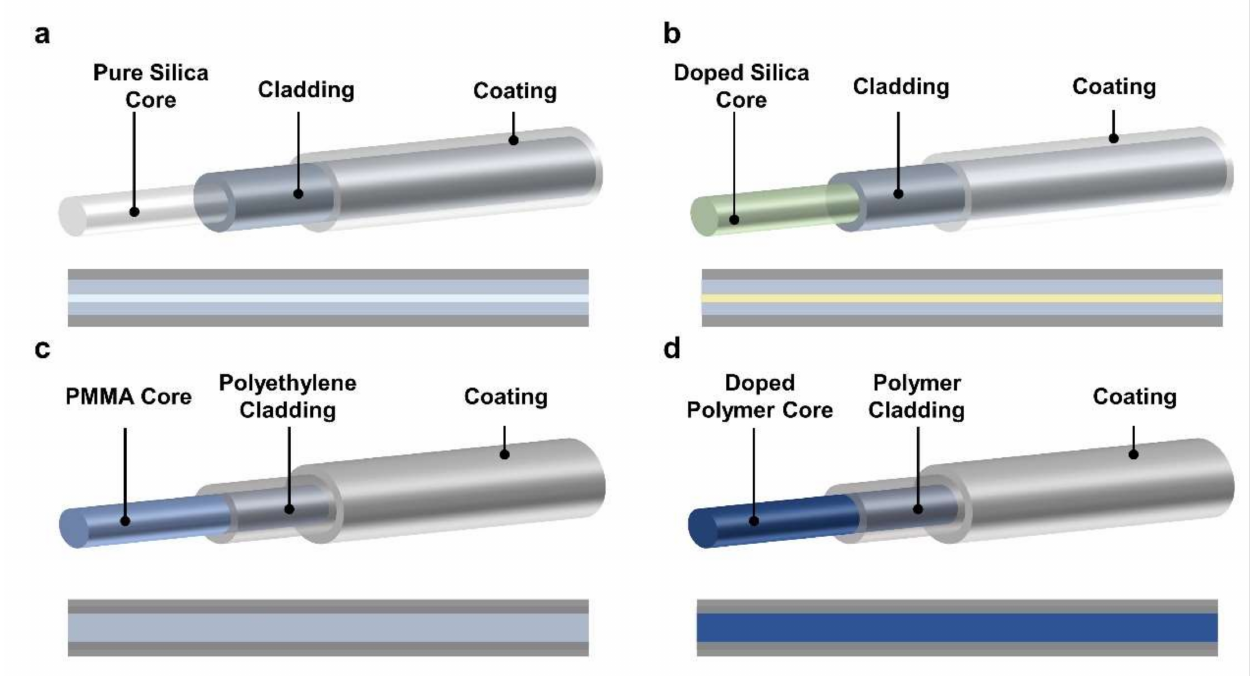
Figure 3. Schematic of widely used fiber radiation sensor based on the RIA principle. ( a , b ) silica and doped silica optical fibers. ( c , d ) PMMA and doped functional polymer optical